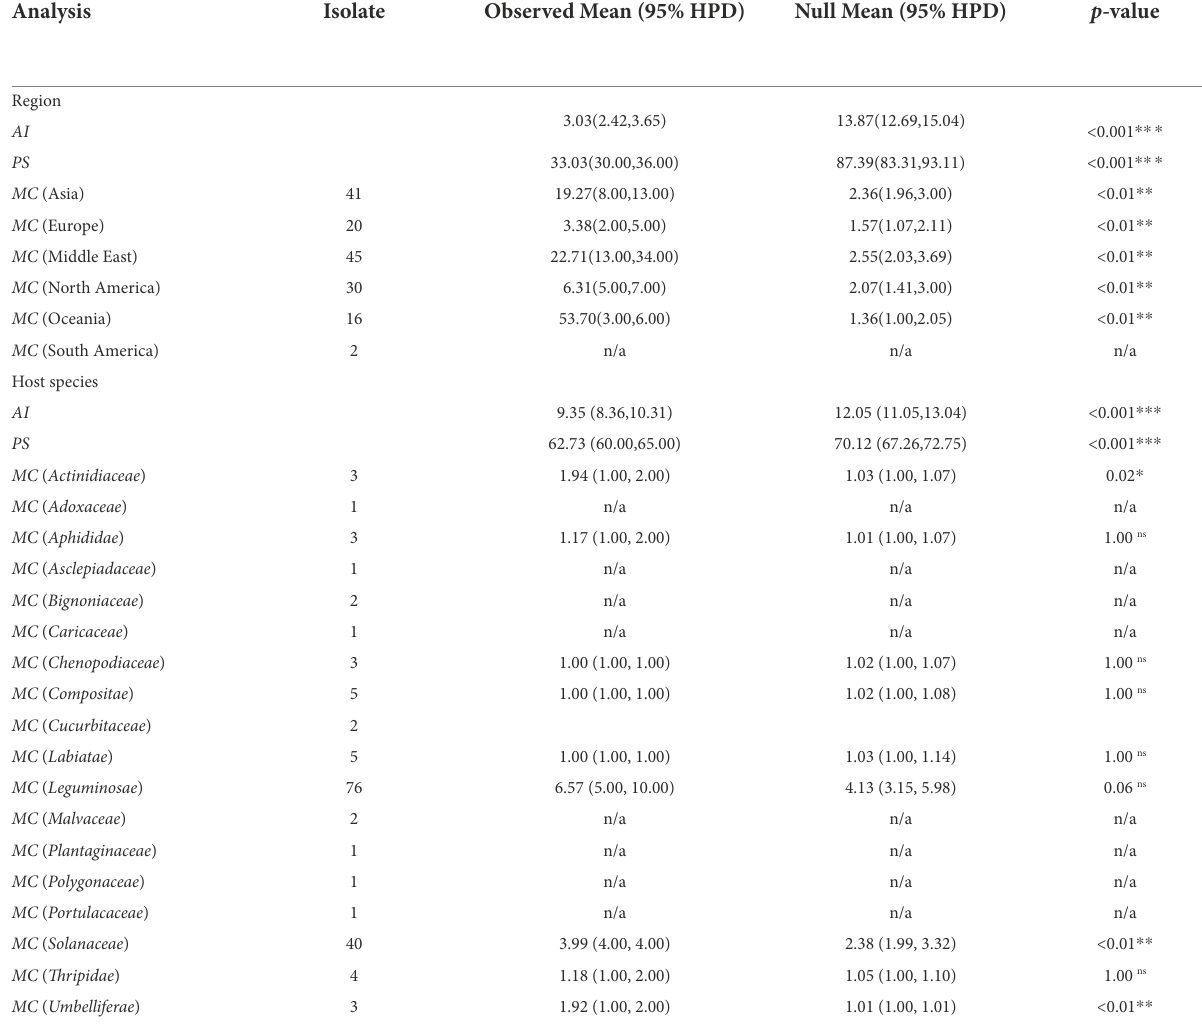
TABLE 2 Analysis of the geographical and host effects on the structure of AMV isolates.